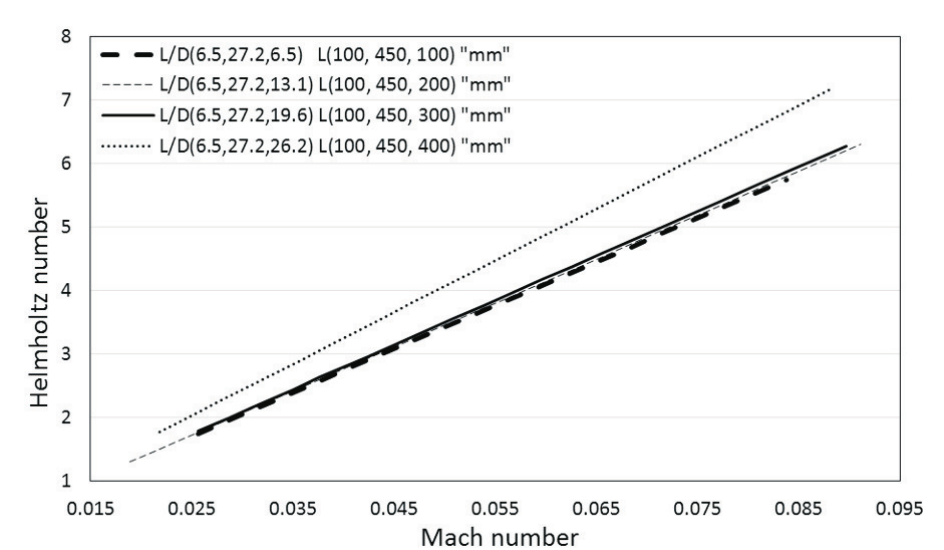
Figure 13. Helmholtz number He plotted against Mach number M for L up = 100 mm, L corr = 450 mm, and L dw = 100–400 mm. Table 9. Mach number and corresponding Helmholtz number ( He ) range for pipe systems in Case a-III. L up (mm) L corr (mm) L dw (mm) Mach Number Range Corresponding He Range